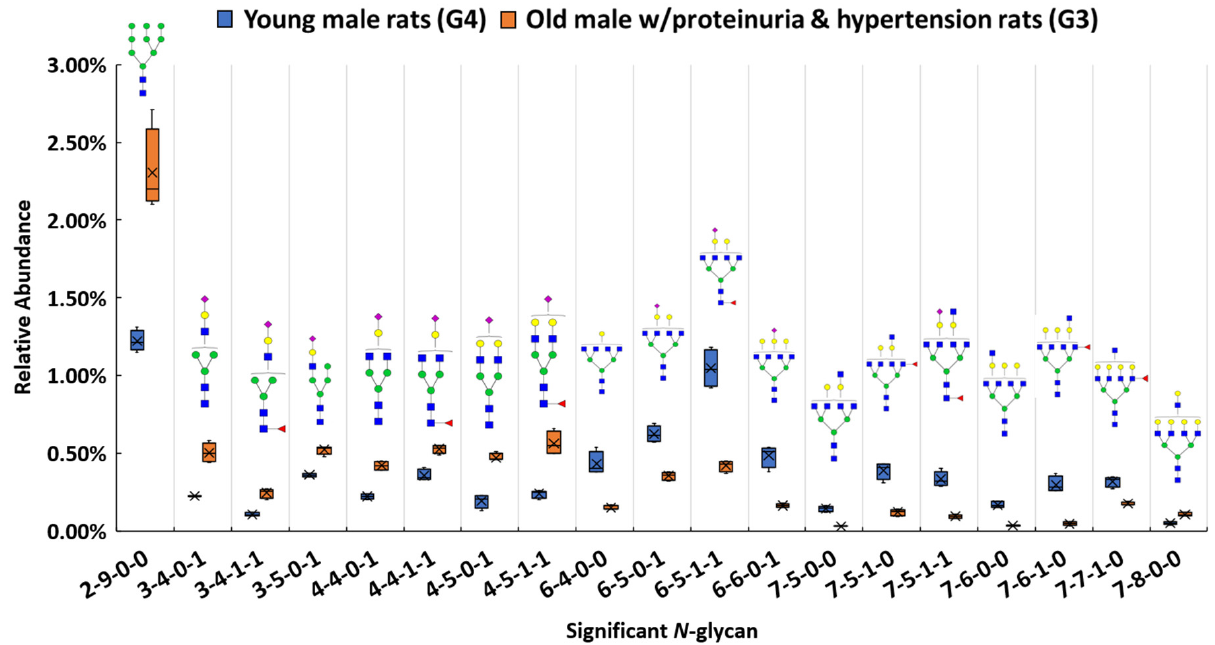
Figure 2. Box plot for relative abundance of 19 significant N -glycans ( p < 0.0004) between old male with proteinuria and hypertension (G3) and young male control (G4). The putative structure was assigned to each glycan composition. The X axis denotes the four-digit codes for N -glycan compositions. The Y axis is the relative abundance. The four-digit codes represent N -glycan compositions. X-X-X-X stands for HexNAc-Hexose-DeoxyHex-NeuAc. HexNAc includes N -acetylglucosamine and N -acetylgalactosamine. Hexose includes galactose and mannose. Deoxyhexose is fucose and NeuAc is N -acetylneuraminic acid.